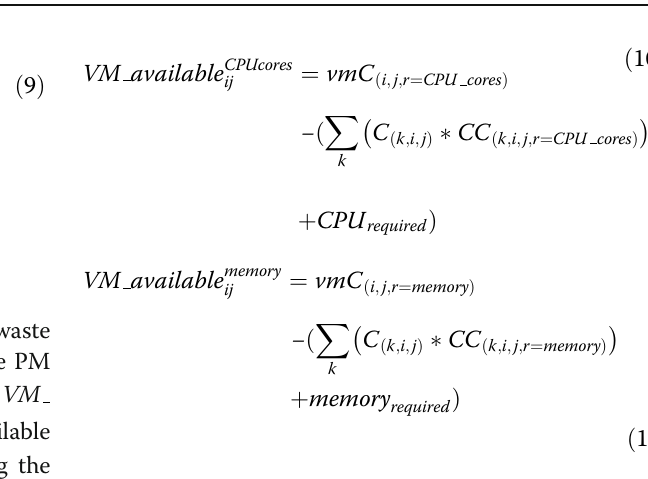
Fig. 8 A sample of the vCore and memory requests for 1000 tasks